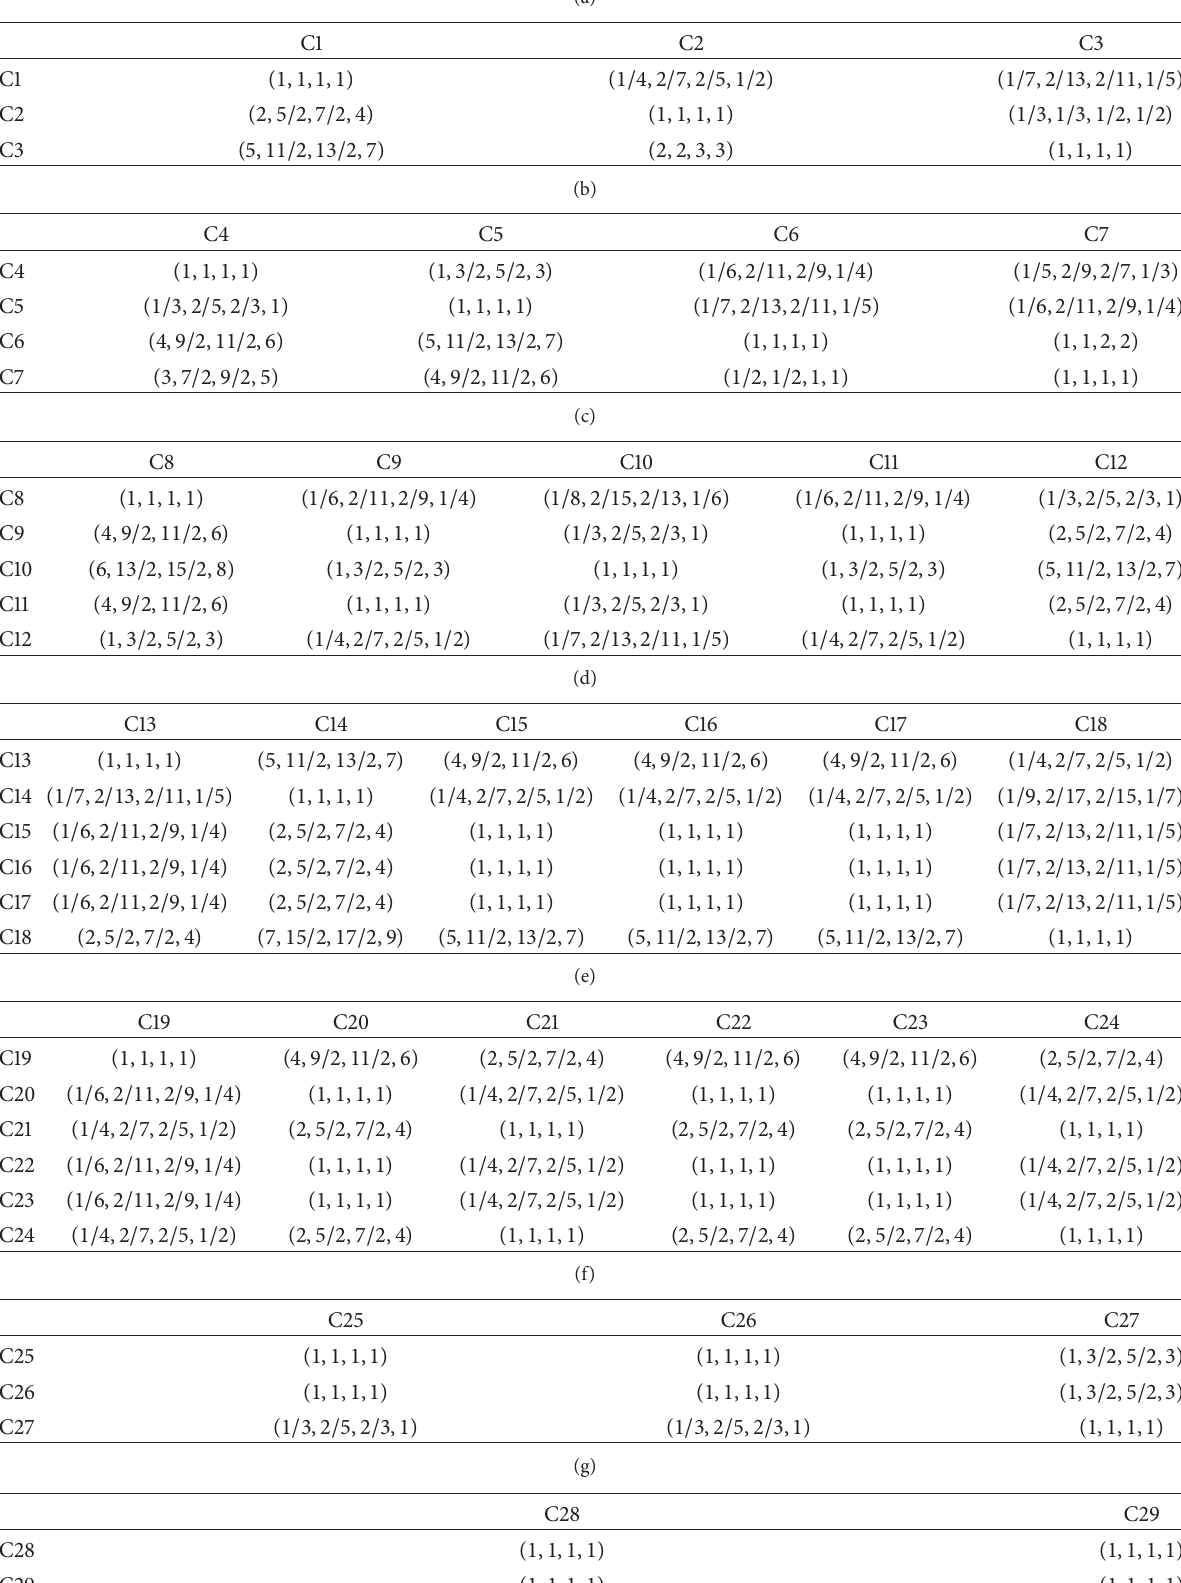
Table 8: Scale of relative importance used in the pairwise comparison of AHP for 4-level